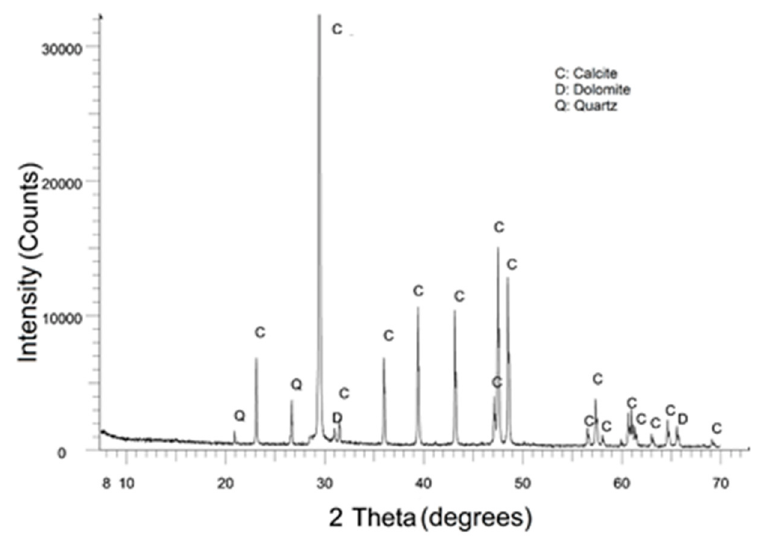
Figure 4. XRD pattern of quarry dust.